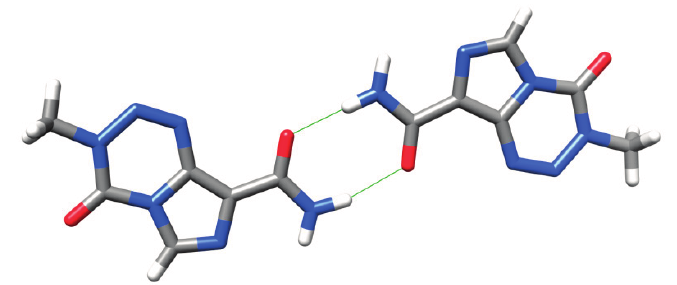
Figure 7. Dimers seen in Lowe’s crystal structure of TMZ [33]. Strong H-bonds are shown in